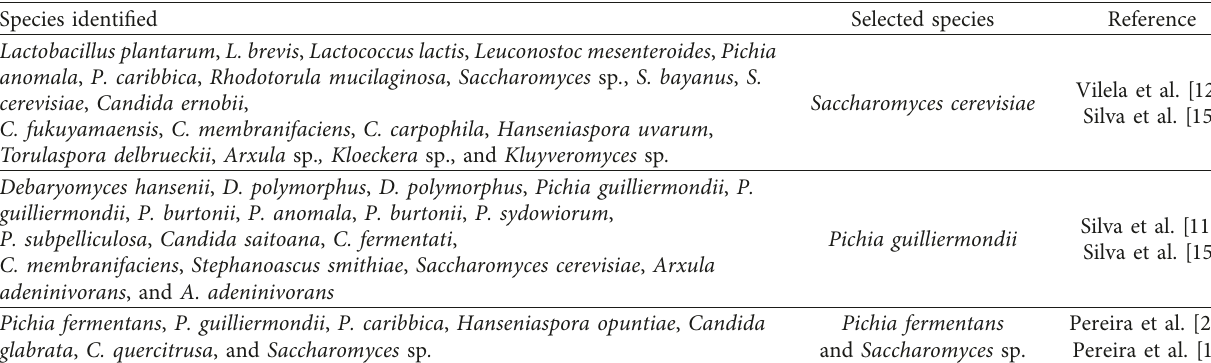
Table 4: Microbial ecology of yeasts and bacteria of coffee fermentation from which starter culture selected. Species